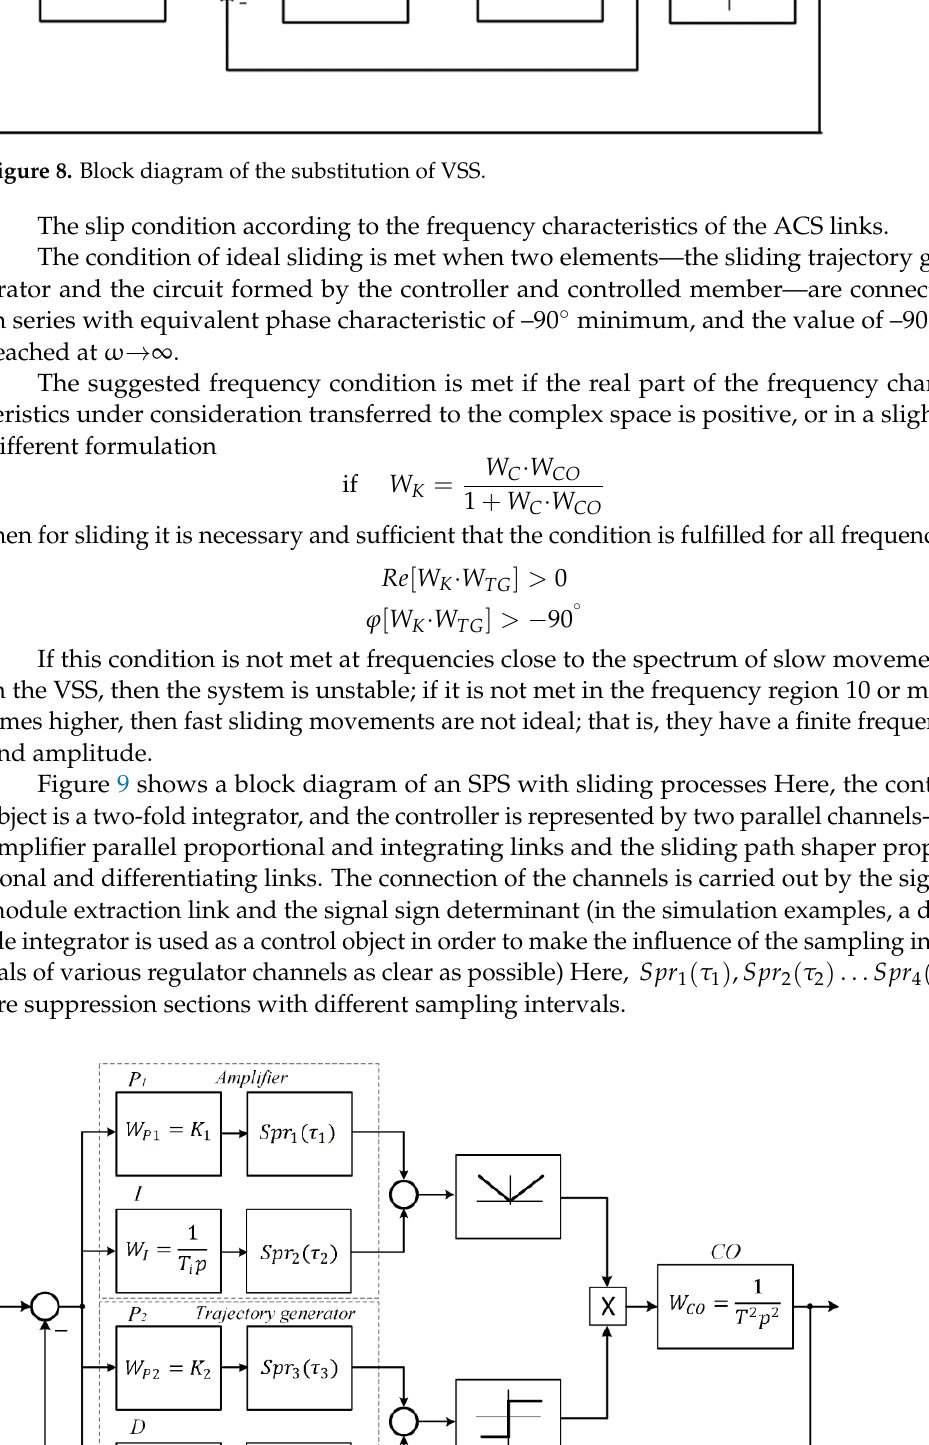
Figure 7. Block diagram of a system with a variable structure regulator (VSR).